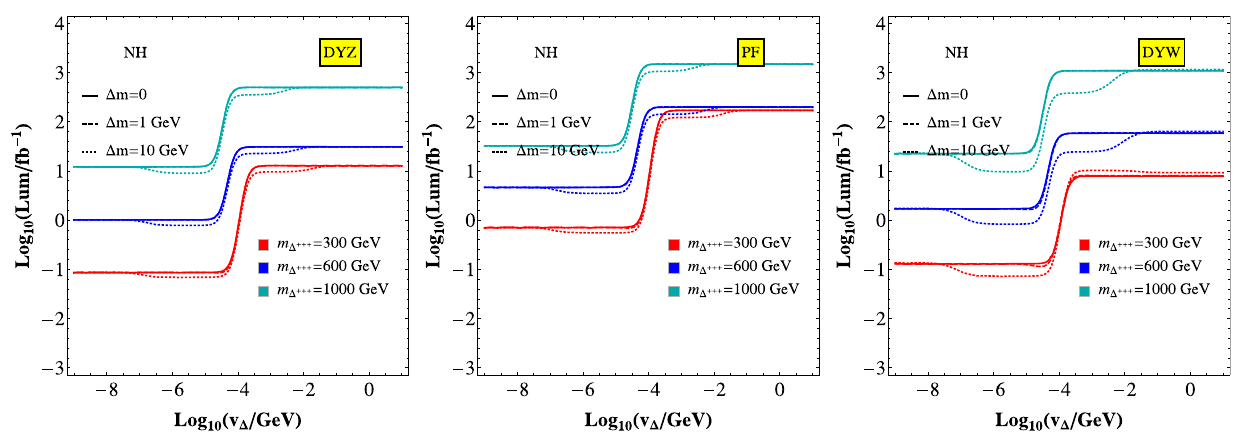
Fig. 8 5 σ discovery prospects of searching for triply charged Higgs boson at a 100 TeV pp collider with SS3L signature in the DYZ, PF and DYW processes. The benchmark scenarios with (cid:2) m = 0 , 1 , 10 GeV and m (cid:2) ±±± = 300 , 600 , 1000 GeV for the NH and IH are depicted in the plane of log 10 (v (cid:2) / GeV ) and log 10 ( L / fb − 1 )